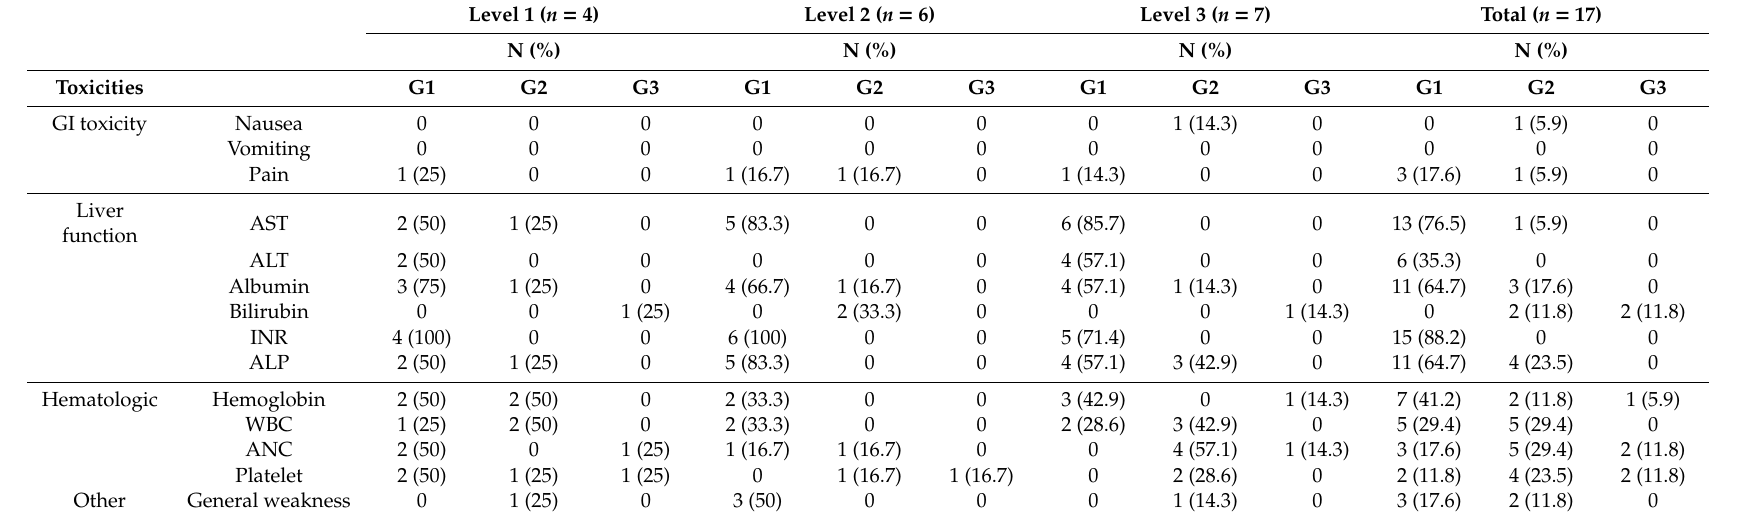
Table 3. Treatment-related toxicities within 3 months after concurrent